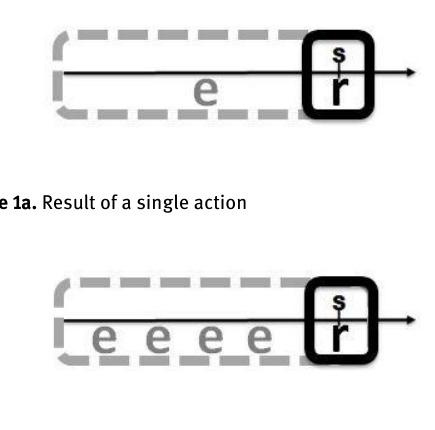
Figure 1b. Incremental result of iterated